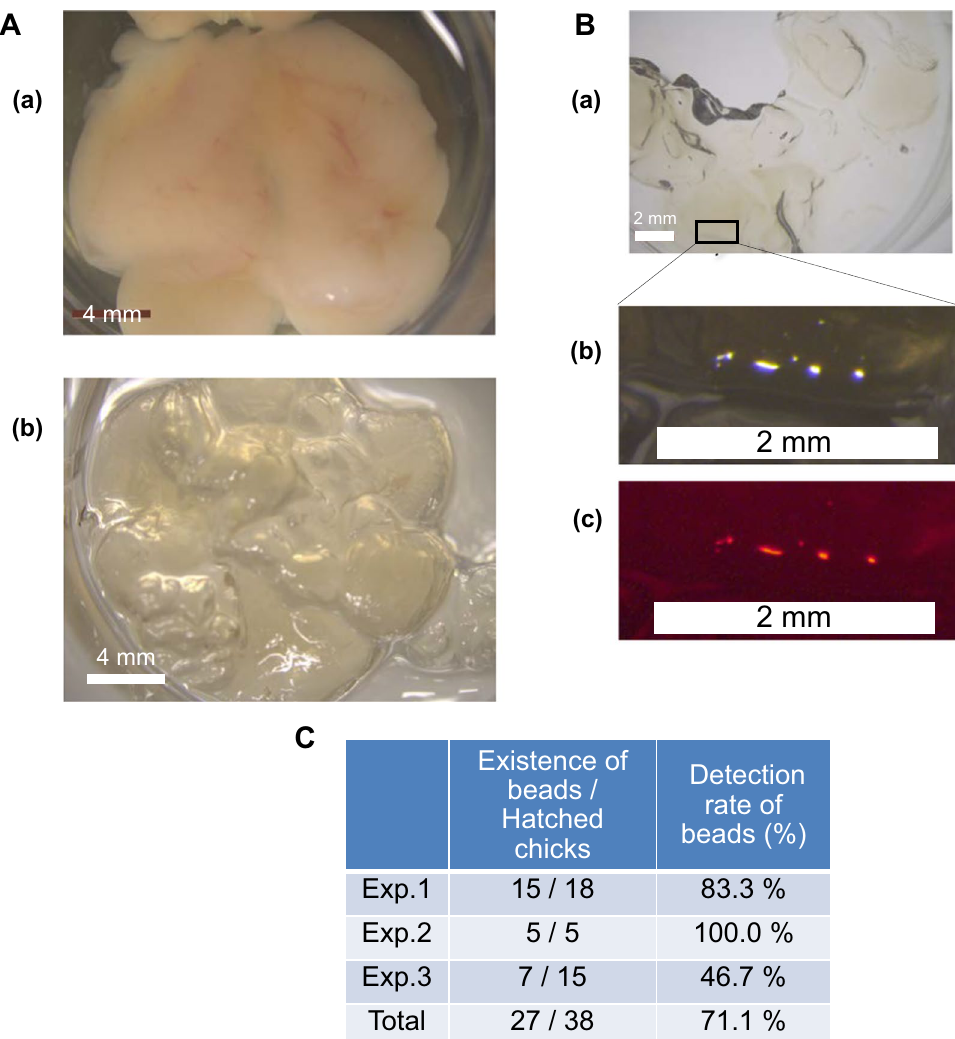
Fig. 6 Fluorescent beads in the head area of hatched chick. A Transparent treatment of the whole brain. Photographs of (a) the whole brain fixed with 4% paraformaldehyde and (b) the transparent whole brain. B Multiple beads were detected in the brains. Fluorescent beads in the transparent brain tissue were photographed; (a) a large part of the whole brain (bright field), (b) the restricted region (open rectangle in (a)) (relief contrast), and (c) the same region as in (b) (fluorescence). C The number of brains with beads among the hatched chicks. In three independent experiments (Fig. 5C), the numbers of manipulated brains with fluorescent beads were